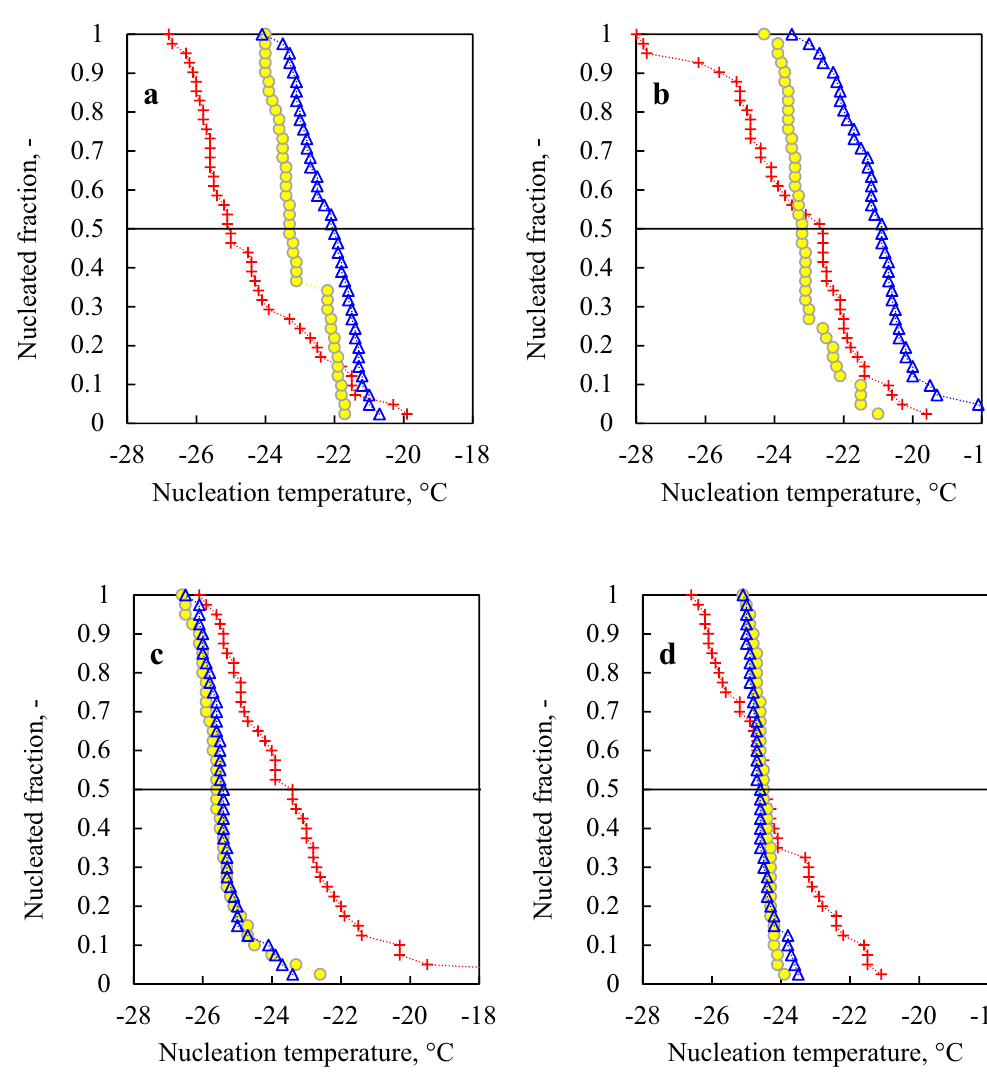
Figure 5. Nucleated fraction vs. nucleation temperature for ( a ) experiment VI, ( b ) experiment VII, ( c ) experiment VIII and ( d ) experiment IX. In all panels: blue triangles, yellow circles, and red crosses correspond respectively to the sub-runs at T th = 20 °C, 40 °C, and 60